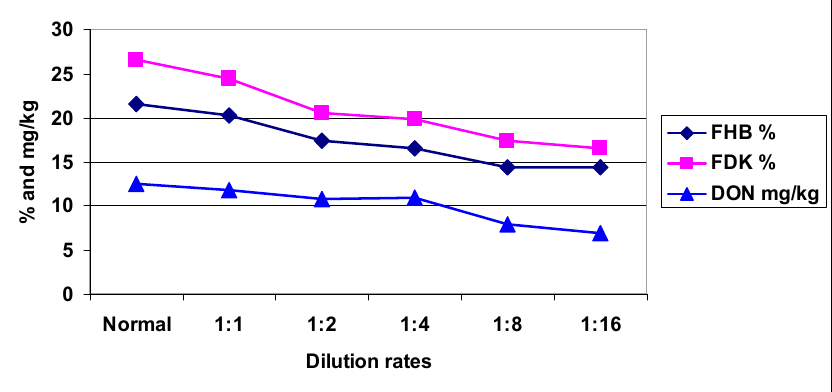
Figure 9. Average aggressiveness of the isolates used for FHB %, FDK % and DON contamination (mg/kg) at different dilution rates across isolates and genotypes, 2013 and 2014. LSD 5% FHB (DI) = 0.89, FDK = 1.41, DON = 1.21.